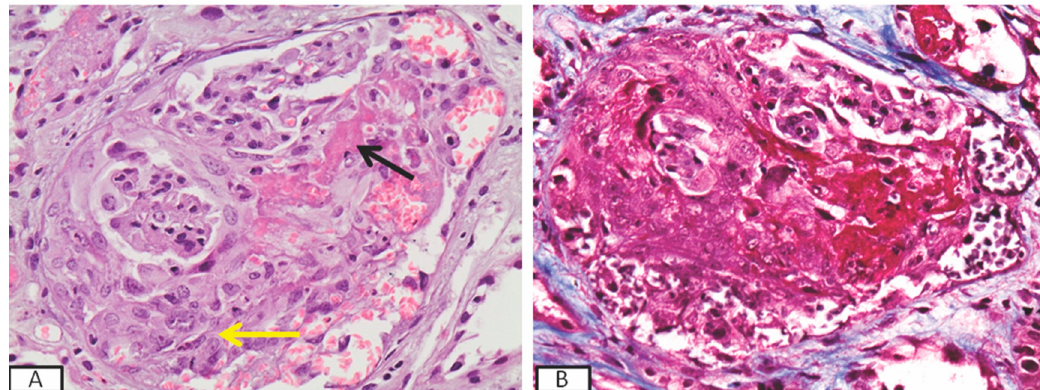
Figure 4. Kidney biopsy of a patient (p. #2, Table 2) who presented with rapidly progressive glomerulonephritis and developed pulmonary–renal syndrome, showing a large cellular crescent (yellow arrow) and segmental fibrinoid necrosis (black arrow) in the glomeruli ( A ) (H&E × 400) by light microscopy and bright red staining of the fibrinoid necrosis in Masson trichrome stain, (Masson × 400) ( B ).